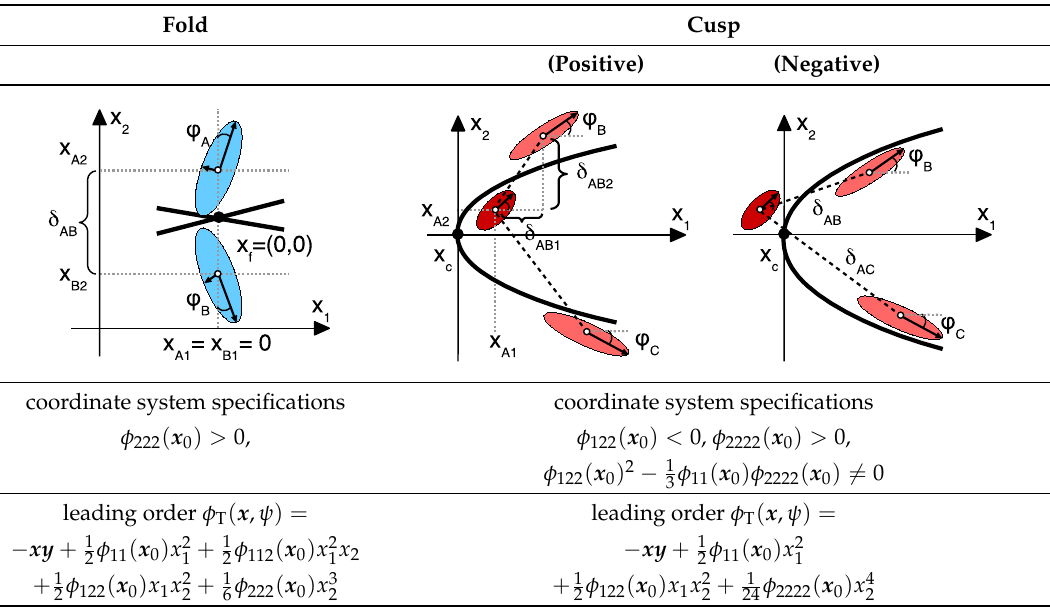
Table 3. Synopsis of approximations to Equation (15) and embedding of the observables for fold and cusp critical points, x f and x c , in the coordinate system of Equation (18). The critical point is marked by a black dot in the figures. Degeneracies arise in the sign of the slope of the critical curve at x f . Depending on the parity of image A , there are two possible configurations for a